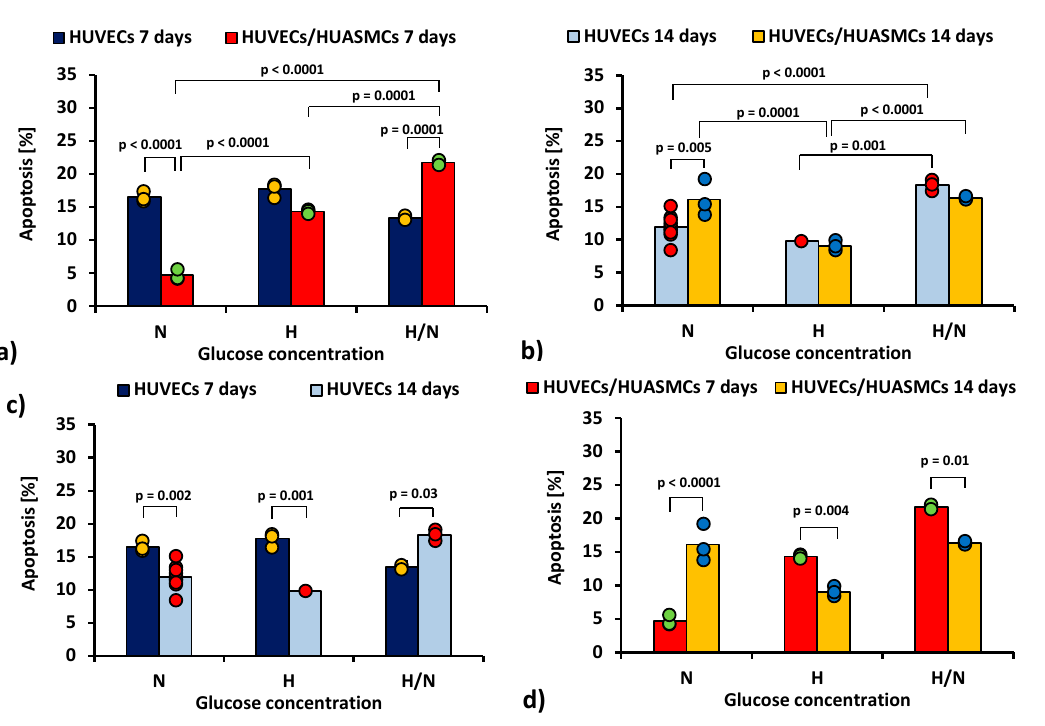
Figure 2. Total percentage of the early and late apoptotic HUVECs: after 7 days of culturing without HUASMCs or co-culturing with HUASMCs ( a ); after 14 days of culturing without HUASMCs or co-culturing with HUASMCs ( b ); after 7 and 14 days of culturing without HUASMCs ( c ); after 7 and 14 days of co-culturing with HUASMCs ( d ); in normal (N), high (H), or variable (H/N) glucose concentration on PSU flat membranes covered with fibronectin. The data are presented as scatter plot (yellow, green, red and blue dots) with corresponding bar graphs. The ANOVA results showed that all of the independent factors but the presence or absence of muscle cells, as well as all interactions of the independent factors in pairs and all three together, significantly influenced the percentage of HUVECs in early or late apoptosis.